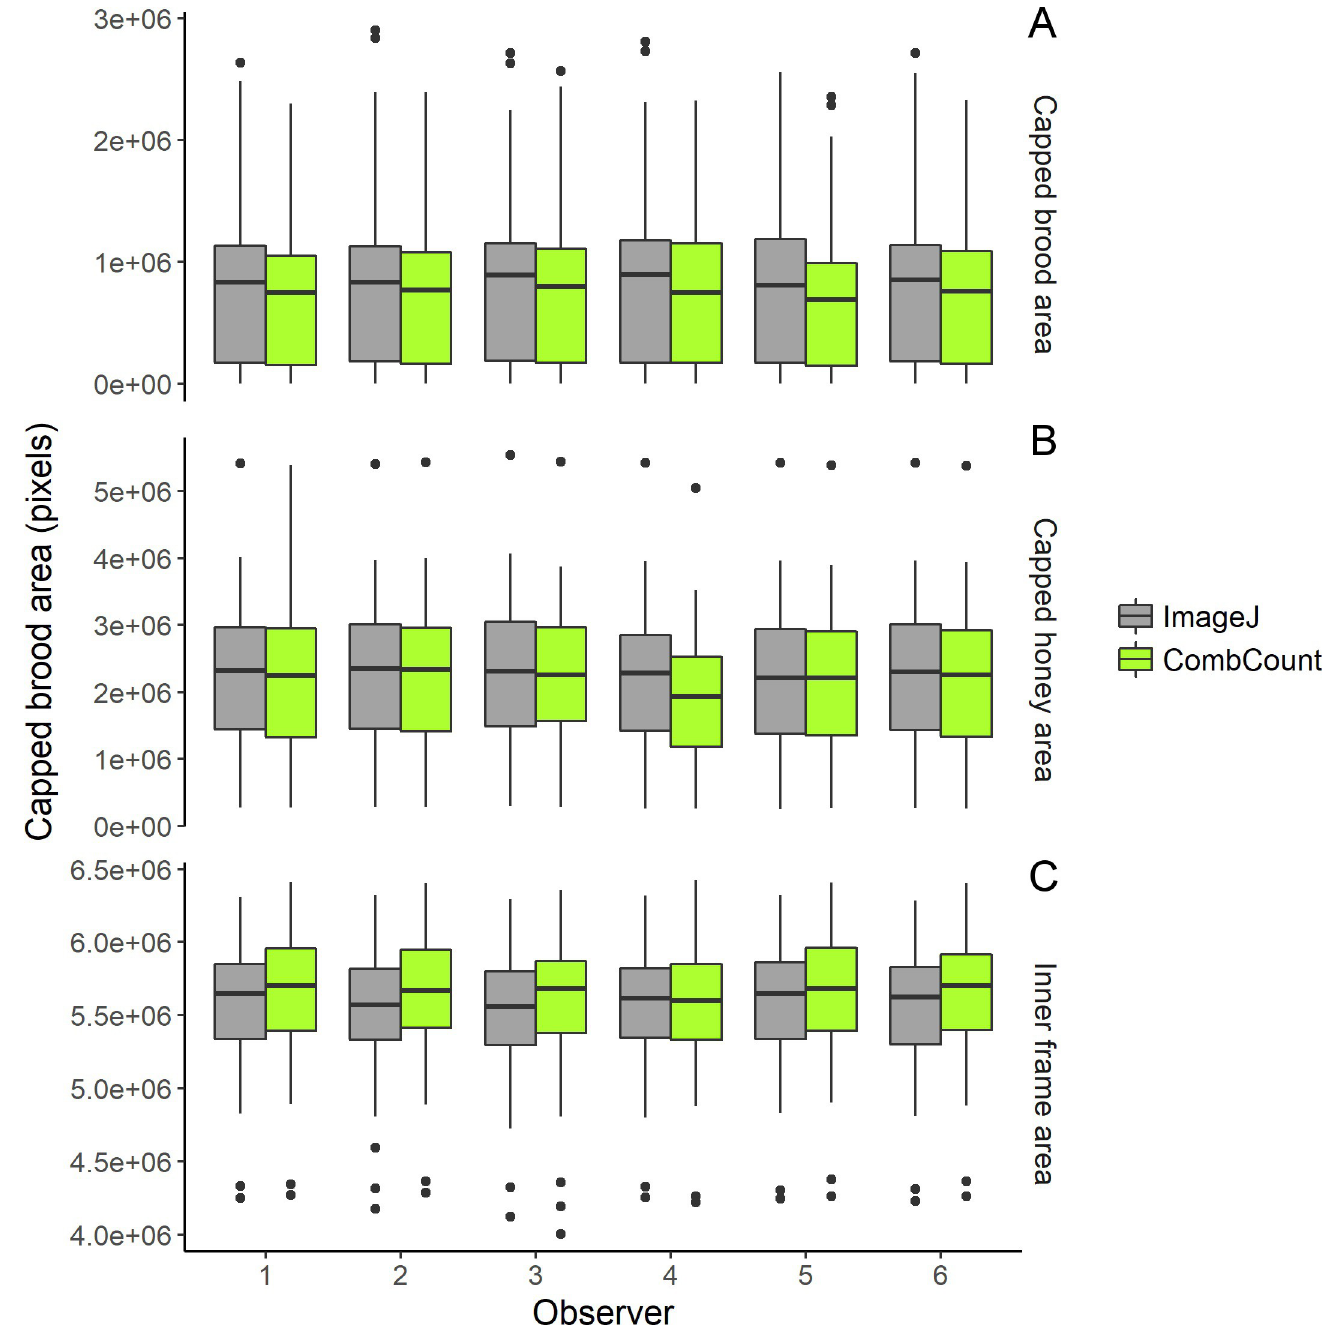
Fig 4. Box and whiskers plots of (A) capped brood area, (B) capped honey area, and (C) inner frame area, with ImageJ and CombCount, by 6 different observers. Measurements with both methods were very similar. Lower and upper edges of the boxes represent the 1 st and 3 rd quartiles respectively, black lines in the boxes represent medians, whiskers extend from minimum to maximum values, values lesser than the 1 st or greater than the 3 rd quartile by more than 1.5 times the interquartile range are shown as